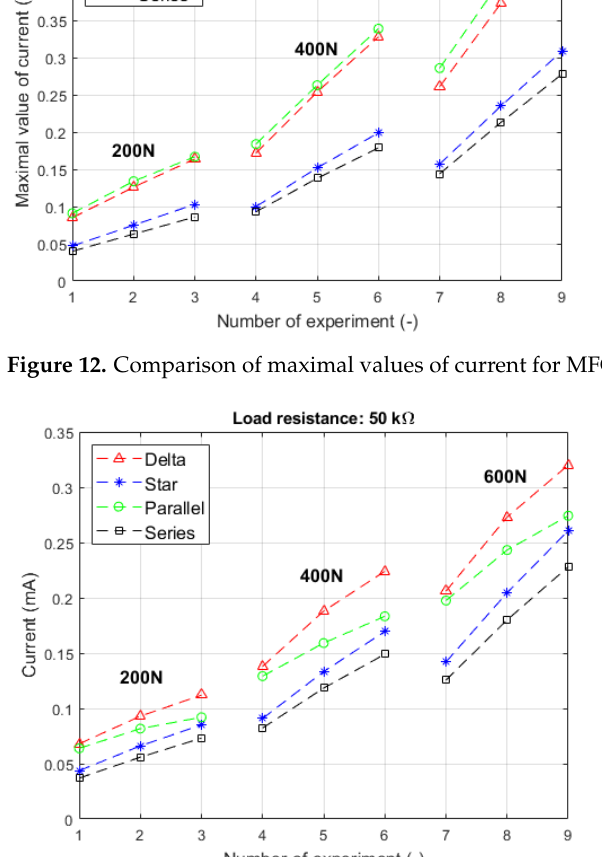
Figure 12. Comparison of maximal values of current for MFC arrays.